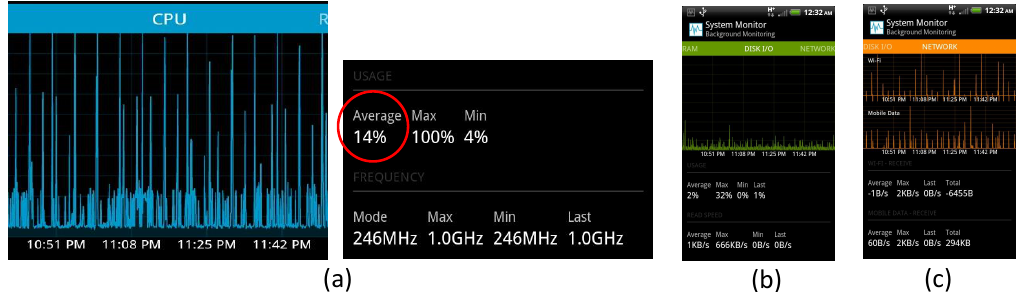
Figure 11. Evaluation of ( a ) CPU, ( b ) network and ( c ) storage I/O usage of the myBlackBox